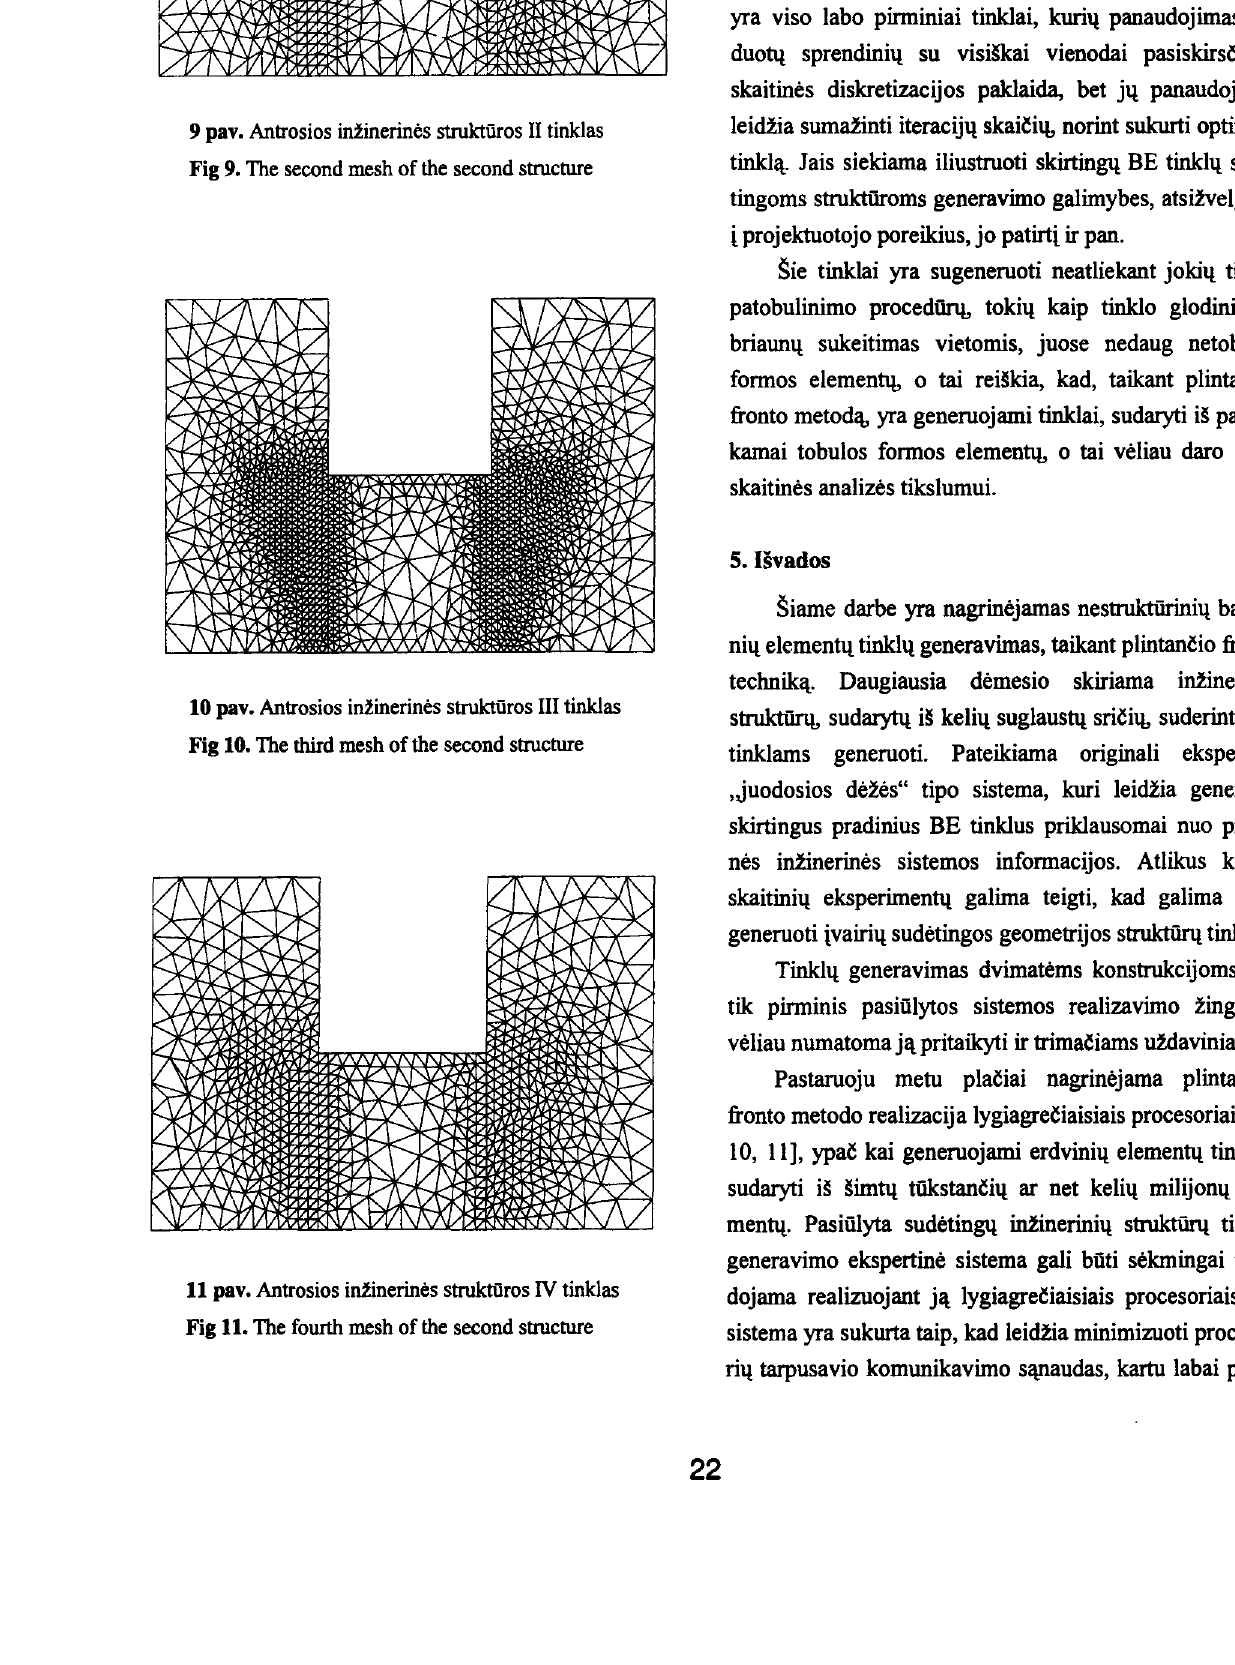
Fig 9. The second mesh of the second structure